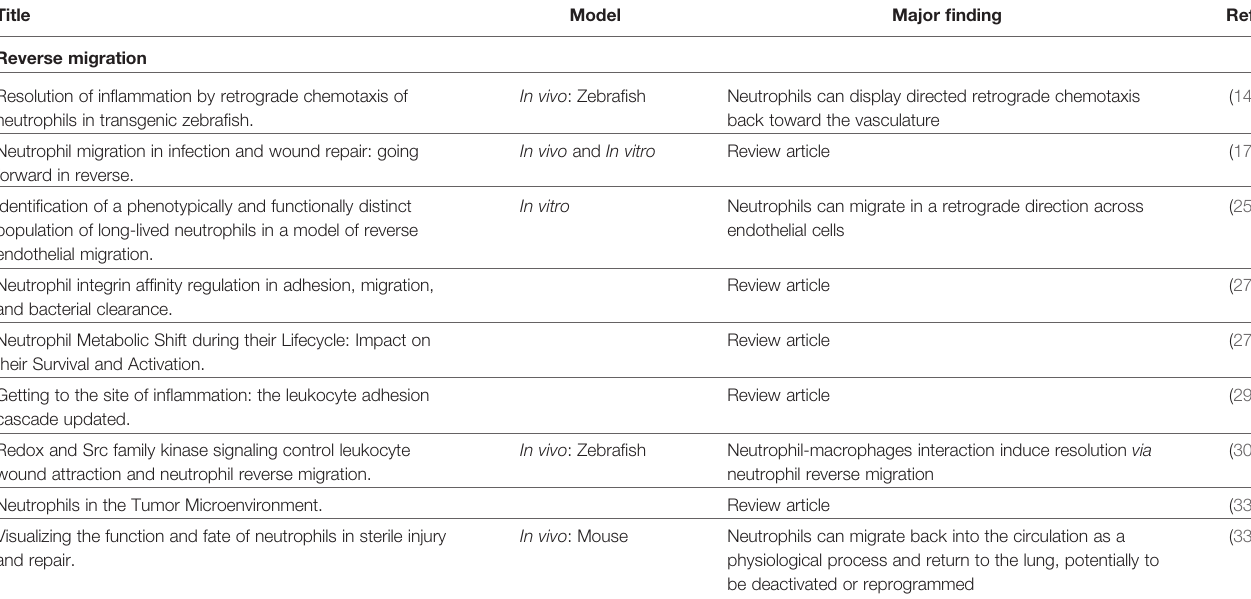
TABLE 1 | Summary of studies on reverse